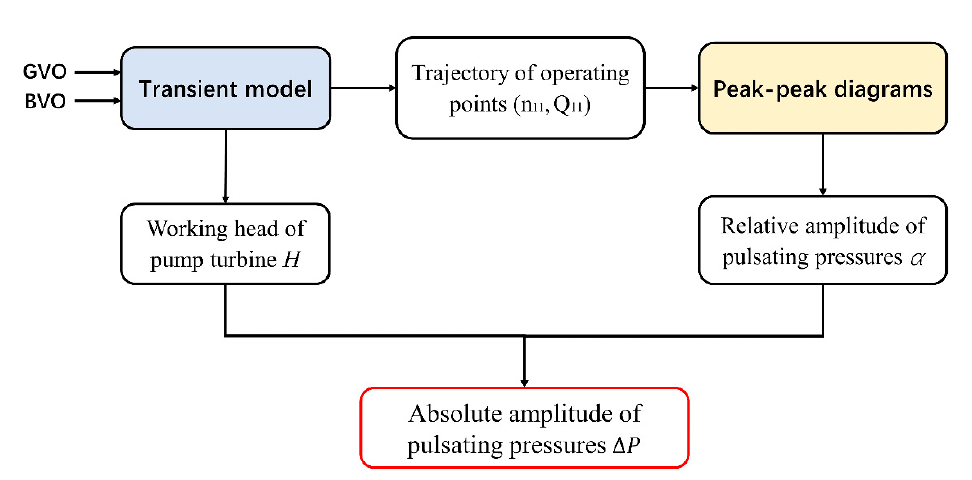
Figure 6. Process of pulsating pressure estimation.